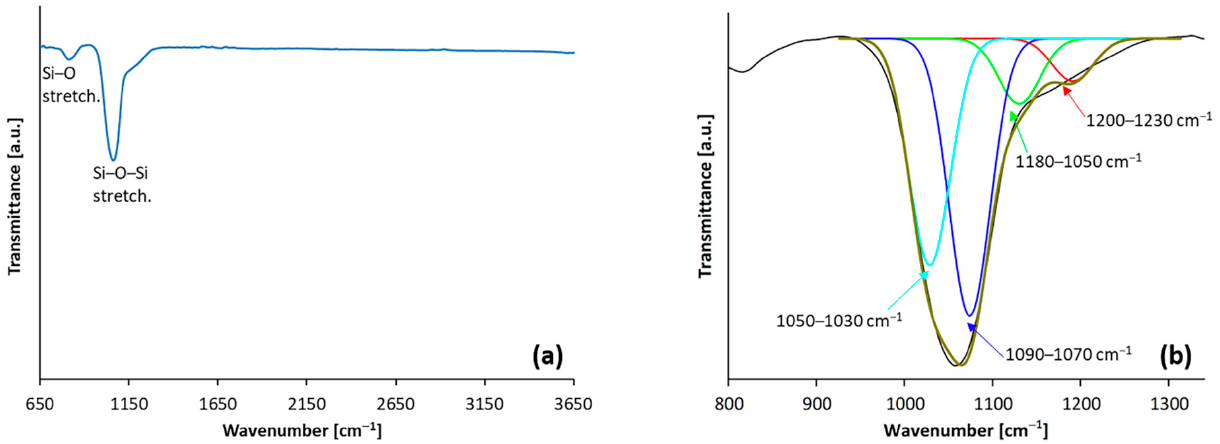
Figure 2. FTIR spectrum obtained for 100 nm of inorganic coating deposited on silicon at 200 W, O 2 /HMDSO ratio 17:1 and 3 Pa ( a ) curve-fitting to deconvolve the Si–O–Si stretching region ( b ).